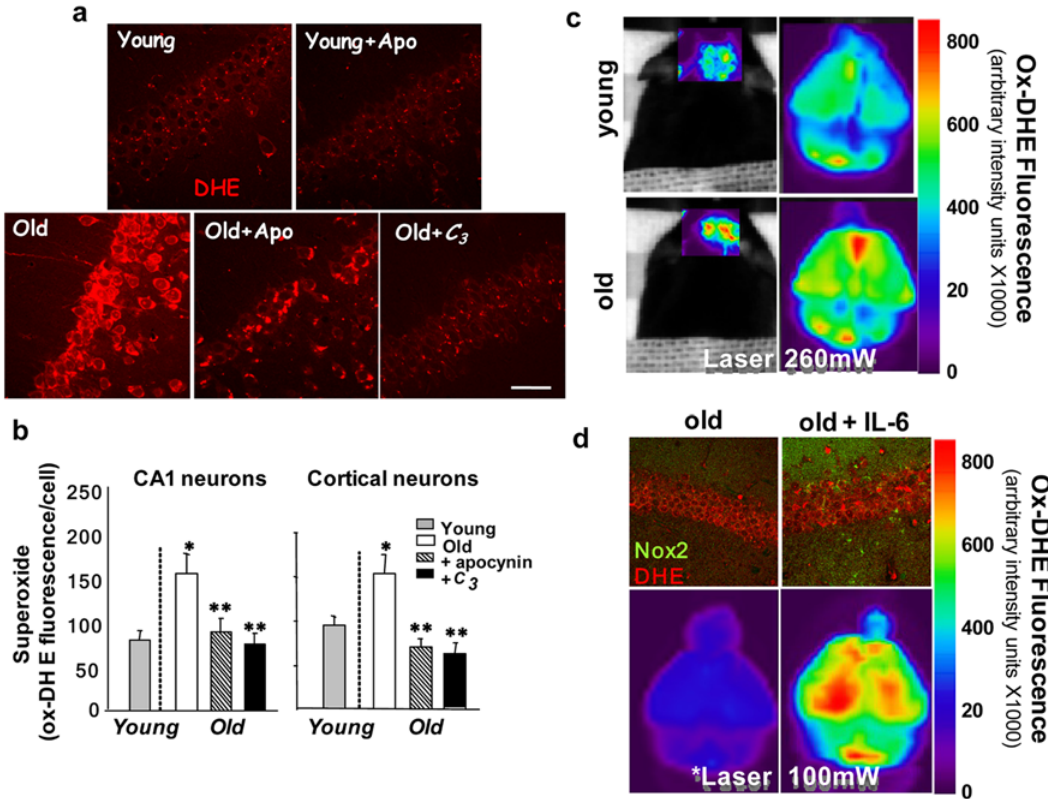
Figure 2. Imaging of invivo superoxide production in brain of young and old animals: role of Nox2 and IL-6. (a) Confocal imaging of in vivo DHE oxidation reveals that superoxide-mediated DHE oxidation is increased in neurons in old mice, and this increase is blocked by the NADPH oxidase inhibitor, apocynin, or by the SOD mimetic, C 3 . Young (4 mo) and old (24 mo) mice were treated orally for 7 days with the Nox inhibitor, apocynin, or for 21 days with the SOD mimetic, C 3 . (b) Quantitative analyses of fluorescence in hippocampal CA1 and cortex were performed as described in detail in the methods section. Images were obtained using a 40 6 WI objective. Values are mean 6 SEM, n=3. Significance was determined by ANOVA: for CA1 (*old versus young, P =0.01;**old versus old + apocynin ( P =0.02) or old + C 3 ( P =0.01) and cortex (Ctx) (*old versus young, P =0.01;**old versus old + apocynin ( P =0.01) or old + C 3 ( P =0.006) by Tukey’s. (c) Live animal imaging of DHE oxidation using a GE eXplore Optix TM -MX2 whole animal scanner also demonstrates increased DHE oxidation in brain of old (24 mo) relative to young (4 mo) mice. Fluorescence images of brain through intact skull and skin are shown on the left , and fluorescence intensity from ox-DHE is mapped onto a linear pseudocolor scale. Images to the right are ex vivo scans of the same brains showing greater anatomical detail, including fluorescence from the cortical hemispheres and cerebellum. (d) Repeated injections of IL-6 on two consecutive days (5 m g/kg) in old mice induced Nox2 expression (top images, green), and produced a small increase in DHE oxidation (red). However, repeated injections of IL-6 every 12 h (5 m g/kg, times three) to produce sustained systemic levels resulted in a dramatic increased in ox-DHE fluorescence compared to saline-injected old controls (bottom images). Note that the laser excitation power was decreased from 260 mW in (c) to 100 mW (d) to avoid saturating the camera in the